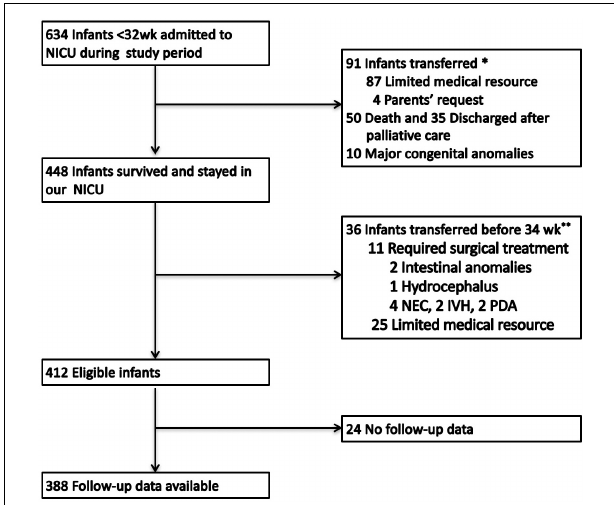
FIGURE 1 | Application of inclusion and exclusion criteria to determine the number of eligible study participants. NICU , neonatal intensive care unit; NEC , necrotizing enterocolitis; IVH , severe intraventricular hemorrhage; PDA , patent ductus arteriosus. *Early transfer: Ninety-one patients were transferred early, within 48 h of birth. Among them, 87 patients were transferred to another tertiary center in our city due to limited medical resources, and four patients were transferred to other hospitals upon parents’ request. **Late transfer: Among the 36 patients transferred before 34 weeks of PMA, 25 were transferred due to limited medical resources, and 11 who required surgical treatment were transferred due to the lack of a surgery department in our